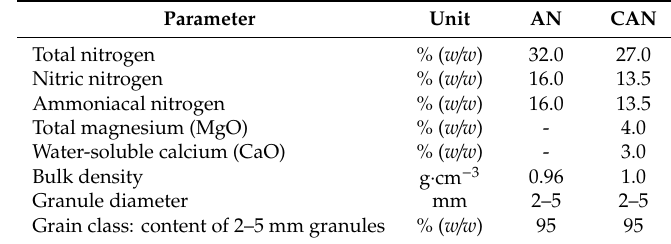
Table 1. Physical and chemical parameters of the examined ammonium nitrate